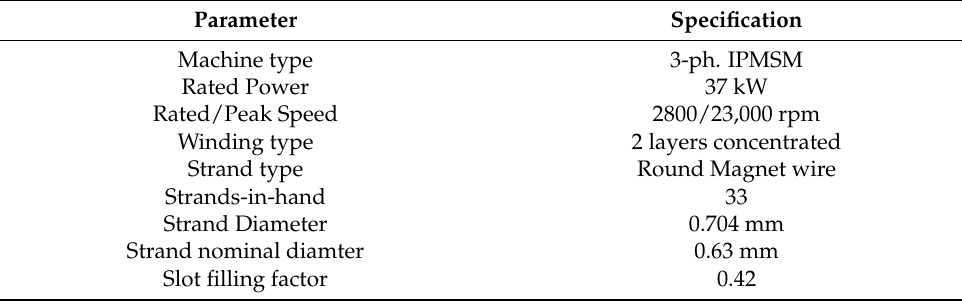
Table 1. Machine parameter and specification.